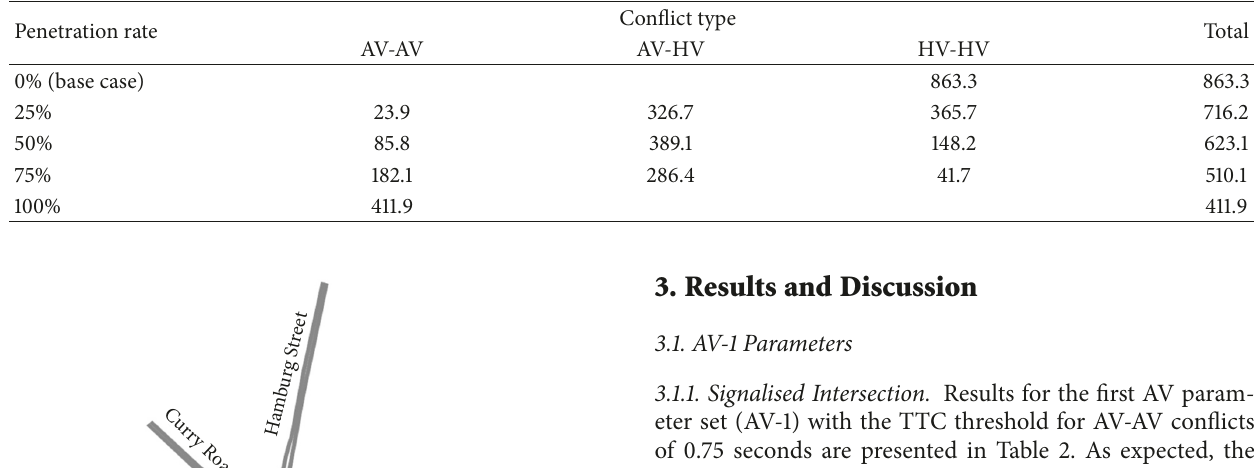
Table 2: Conflicts by types and AV penetration rates for the signalised intersection (AV-1 parameters and 0.75 s TTC threshold for AV-AV conflicts).